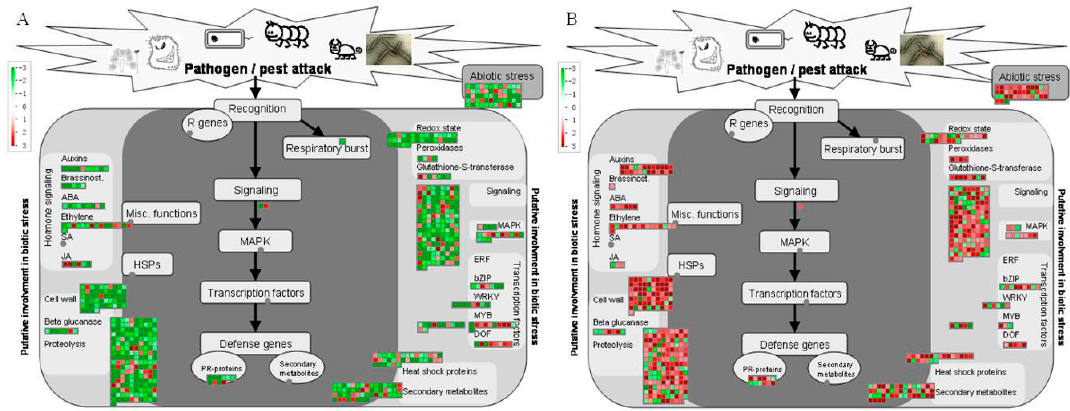
Figure 3. Stress related DEGs regulated by C Las infection at 13 wpi ( A ) and 26 wpi ( B ) respectively in ponkan leaves. Genes significantly upregulated by C Las infection are displayed in red, and those downregulated are shown in green. HSPs: heat-shock proteins; bZIP: basic leucin zipper; ERF: Ethylene response factor; MAPK: mitogen-activated protein kinase; MYB: MYB family transcription factor; DOF: DNA binding with one finger. ABA: abscisic acid; SA: salicylic acid; JA: jasmonic acid; R gene: resistance gene; Misc.: miscellaneous, PR-protein: pathogenesis-related protein, WRKY: WRKY transcription factors, DOF: DNA-binding with one finger.